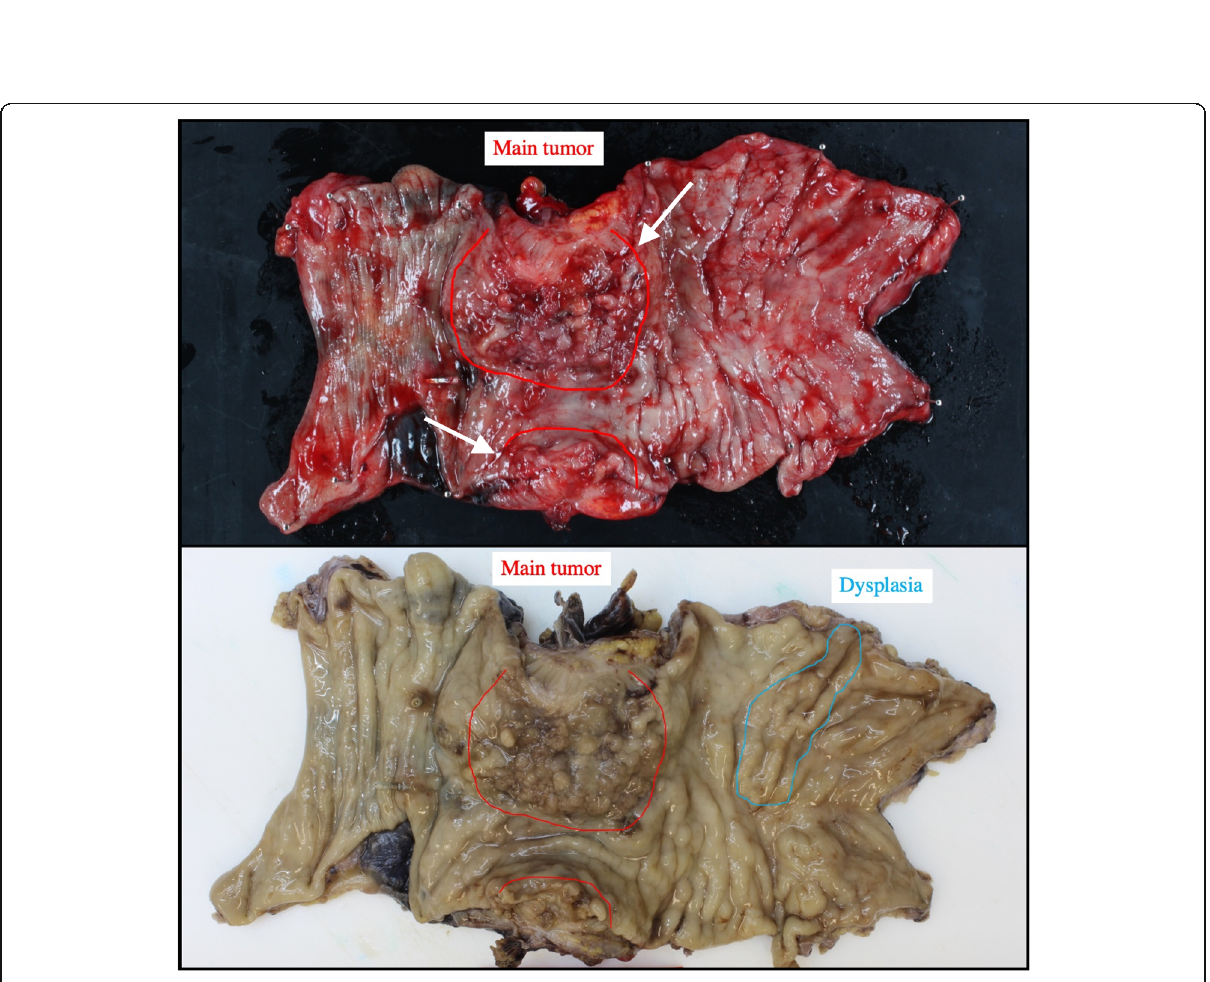
Fig. 3 a The resected specimen of the colon showed the main tumor was a lateral spreading tumor (granular type), 50 × 48 mm in size, in the transverse colon (arrow). b Blue circle indicates another dysplasia, 5.2 × 1.8 cm in suze, near the tumor